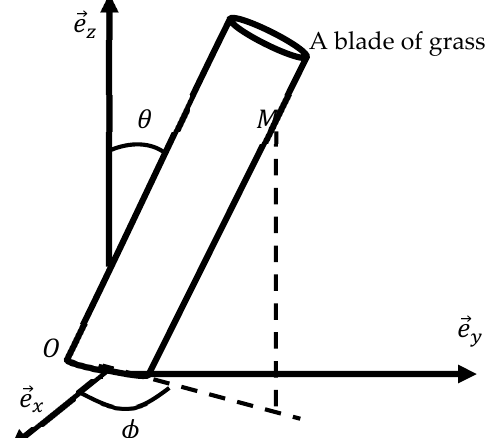
Figure 1. Presentation of the coordinate system and point M on a blade of grass.